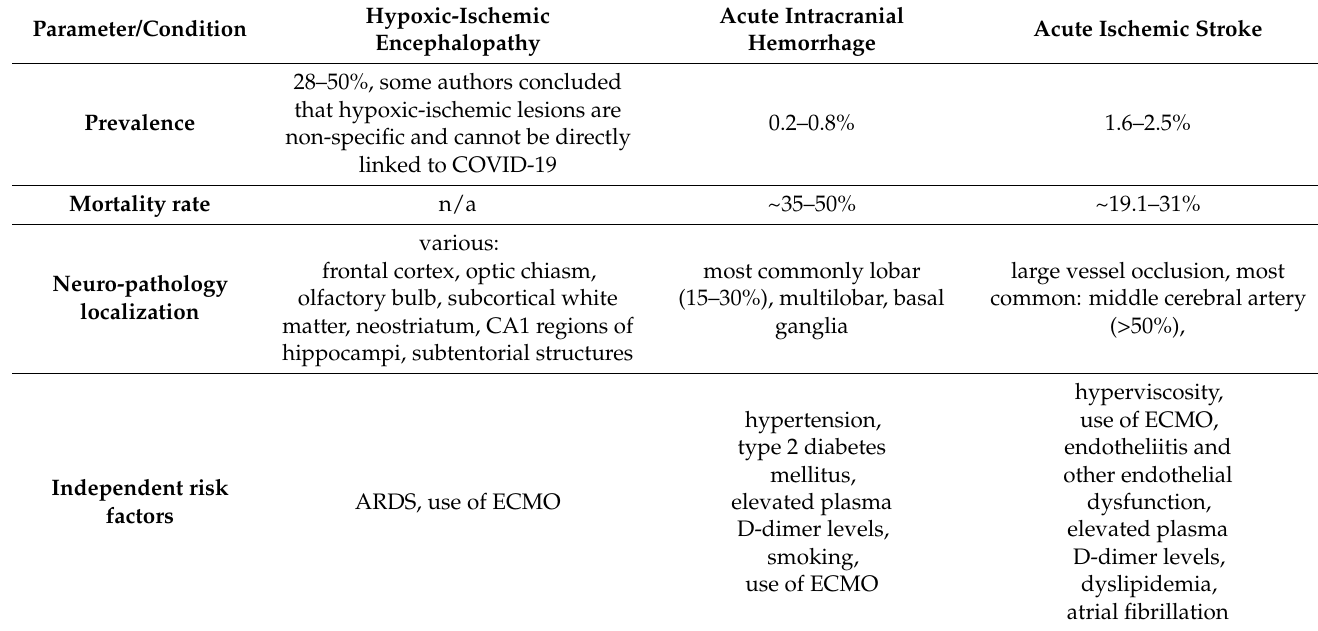
Table 1. Epidemiology, localization, and risk factors of the discussed cerebrovascular conditions in COVID-19